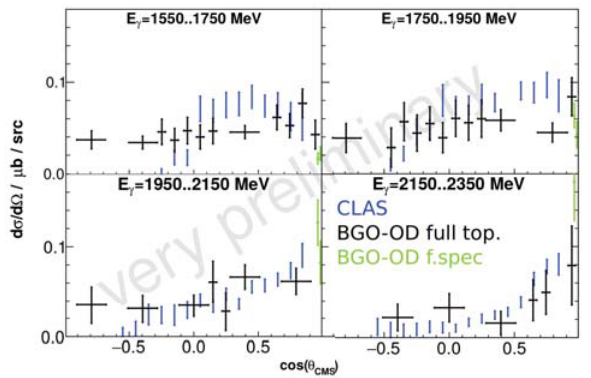
Figure 13. Preliminary γ p → K + ( Λ (1405) → π 0 Σ 0 ) di ff eren- tial cross section using a full topology and forward K + analysis (black and green points respectively). Blue points are previous data of Moriya et al. [37]. Analysis by G. Scheluchin [28].